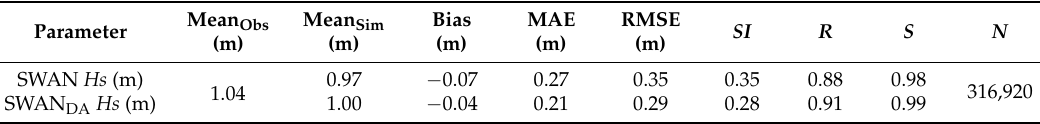
Table 4. Statistical results obtained for the Hs values simulated with SWAN and the Hs values obtained after the application of the DA (data assimilation) method, against altimeter measurements used for validation across the Black Sea, results corresponding to the 15-year time interval (1999–2013).